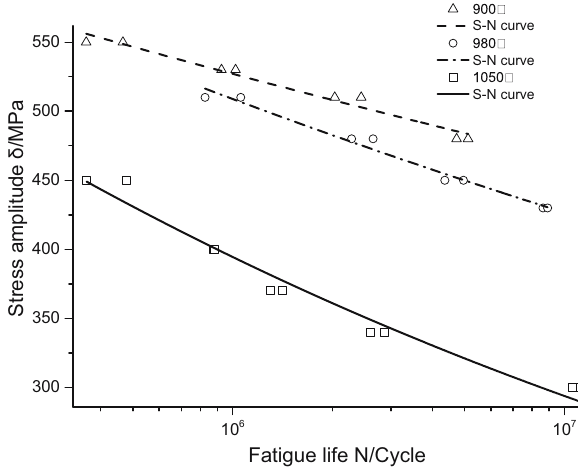
Figure 10: S – N curve of single hole specimens HCF tested at di ff erent temperatures.